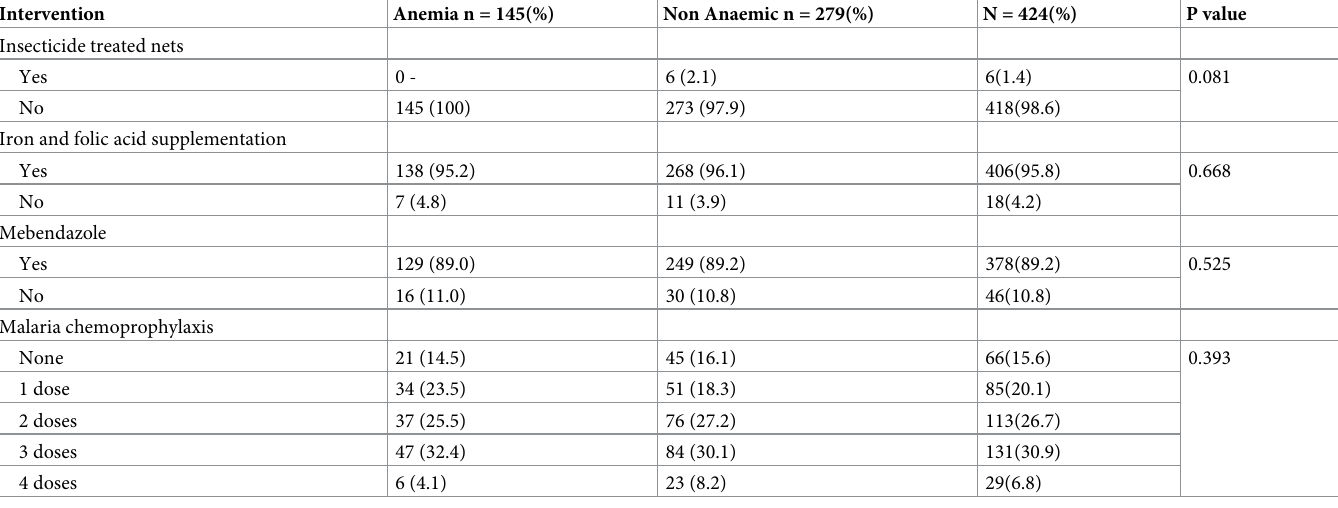
Table 3. Relationship between utilization of Interventions for prevention of anemia during pregnancy and postpartum period at Mnazi Mmoja, Kigamboni and Magomeni Health care facilities (N = 424). Intervention Anemia n =